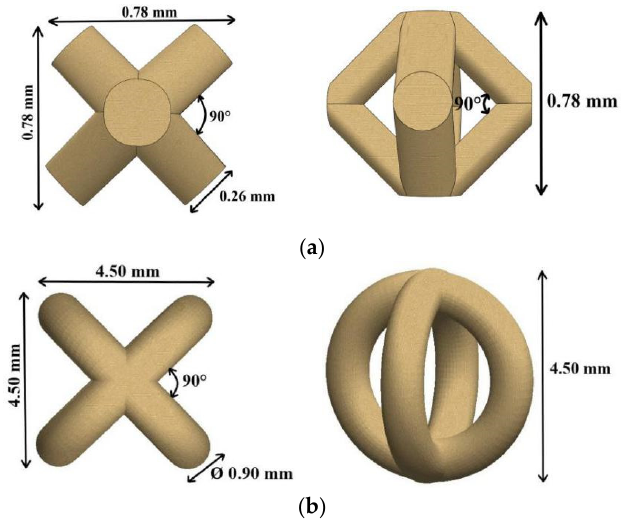
Figure 4. Basic unit cell, top and front views: ( a ) Body-Centered Cubic (BCC); ( b ) Circles Intersection (CI).